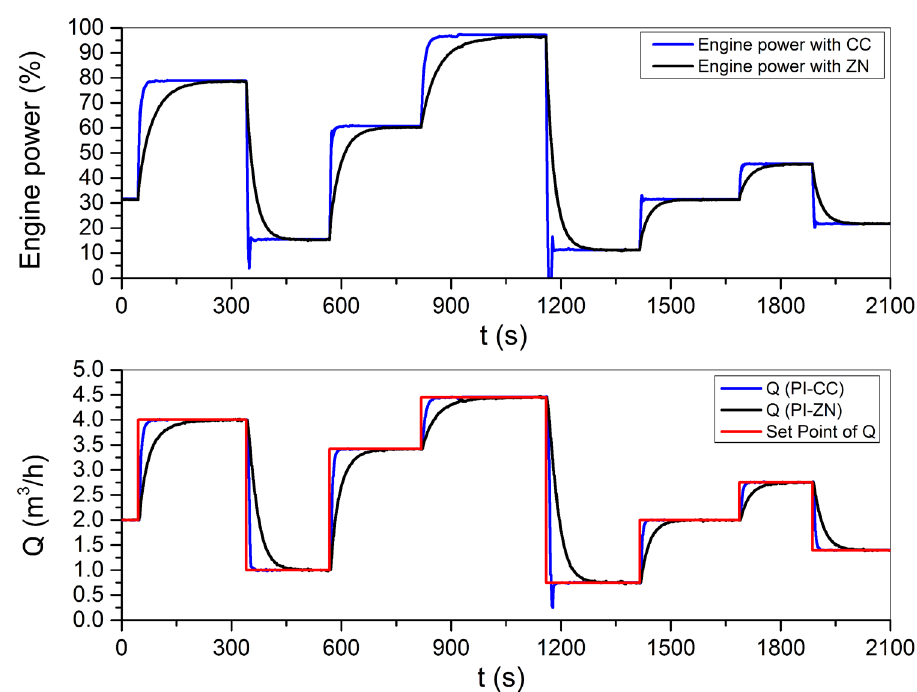
Fig. 8 Flow rate and pump power in function of time during test of setting point